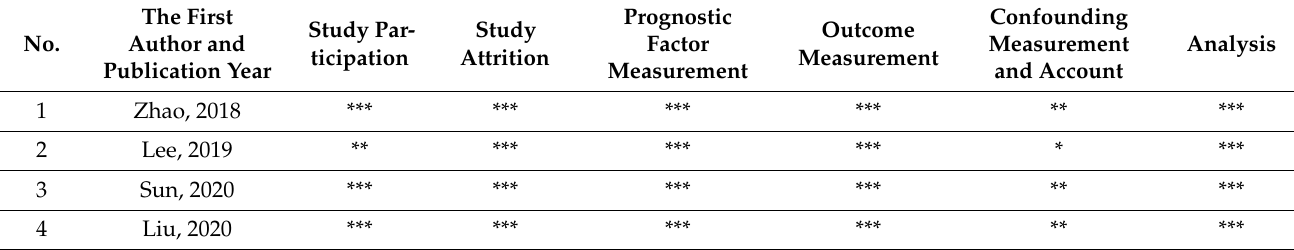
Table 2. Evaluating the potential bias in the included prognostic studies based on the Hayden et al. statements.